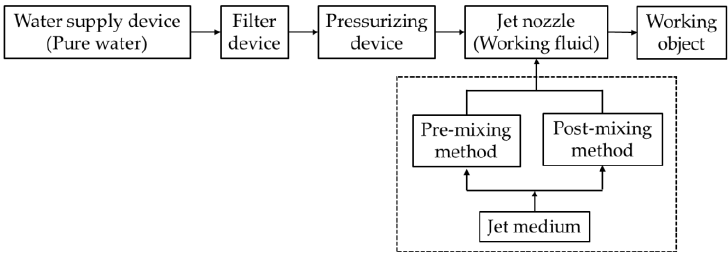
Figure 1. Operation flow chart of water jet cutting system.